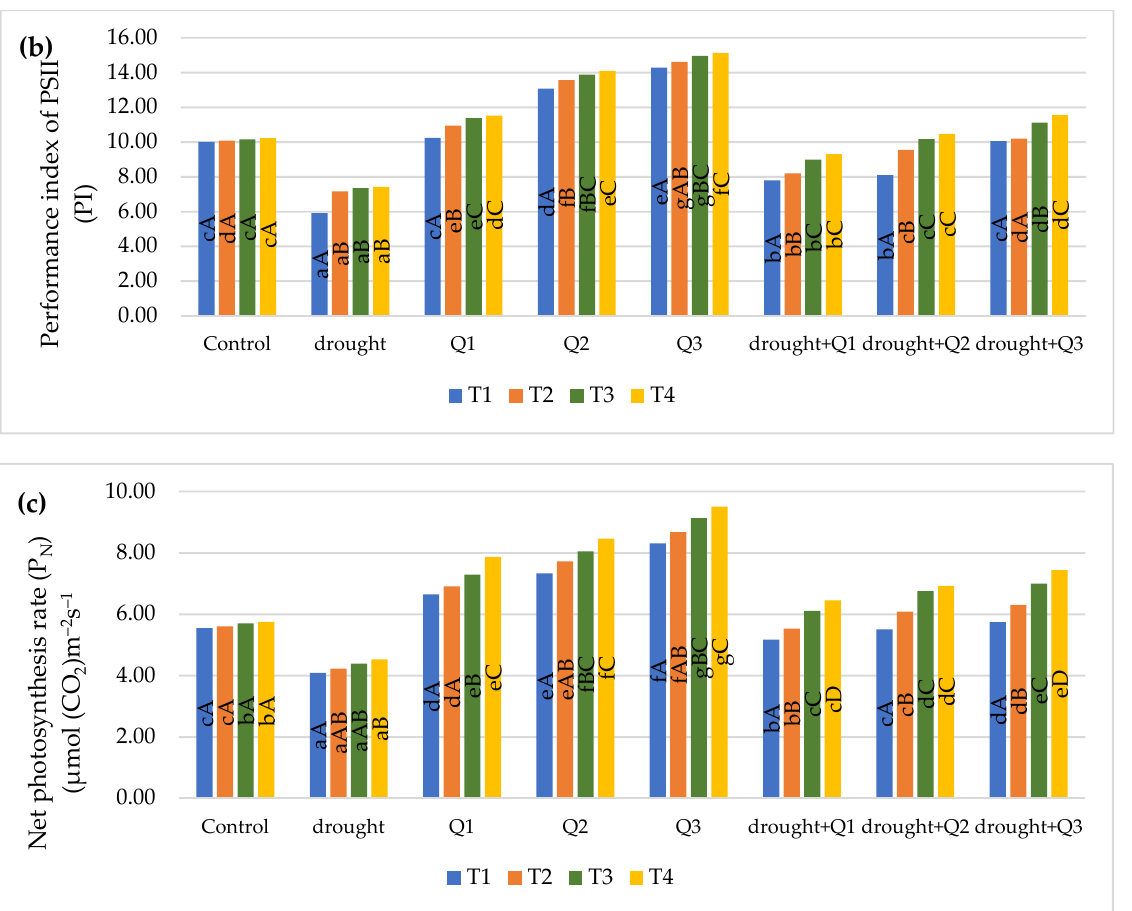
Figure 1. Effect of quercetin derivative concentrations, drought stress and terms of measurement on physiological parameters: ( a ) relative chlorophyll content; ( b ) performance index of PSII (PI); and ( c ) net photosynthesis rate (P N ). (T1—first day after the first treatment, T2—seventh day after the first treatment, T3—first day after the second treatment, T4—seventh day after the second treatment). Capital letters indicate significant differences between the means at measurement terms for each quercetin derivative concentration; lower-case letters indicate significant differences between the means at respective measurement terms according to ANOVA (followed by Tukey’s HSD test, p = 0.05).